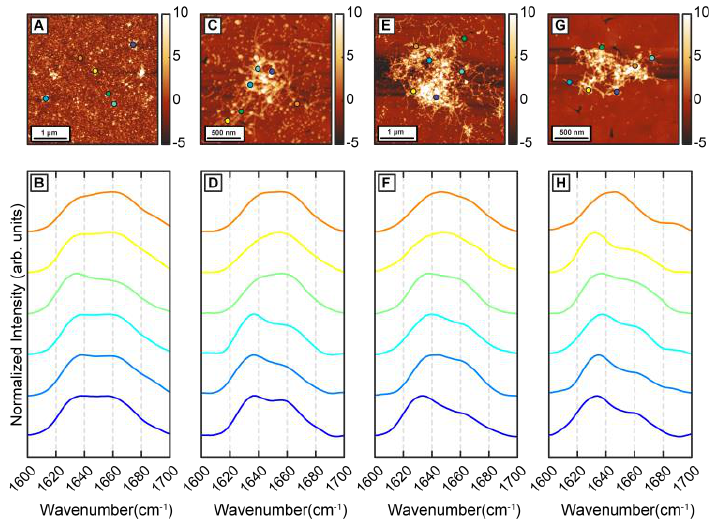
Figure 1. AFM- IR structural characterization of Aβ42 aggregates. ( A ) AFM topograph of Aβ42 oligomer formed after 1 h of incubation. ( B ) Representative IR spectra obtained from several oligomers. ( C ) AFM topograph of Aβ42 fibrils generated after 6 h and ( D ) representative IR spectra obtained from the sample. ( E ) AFM image of Aβ42 fibrils after 24 h and ( G ) 72 h. IR spectra obtained from several points on fibrils from ( F ) 24 h and ( H ) 72 h sample. Dots on the AFM topographs show the corresponding location of IR spectra.